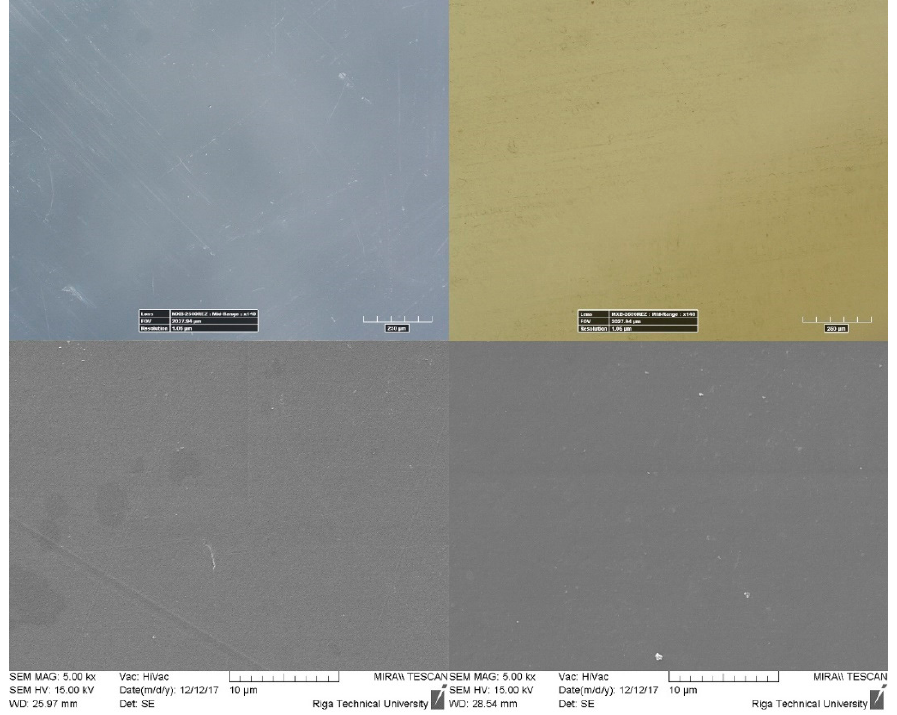
Figure 3. Digital optical ( top ) and SEM ( bottom ) micrographs of initial dry ( left ) and redried after hygrothermal aging ( right ).